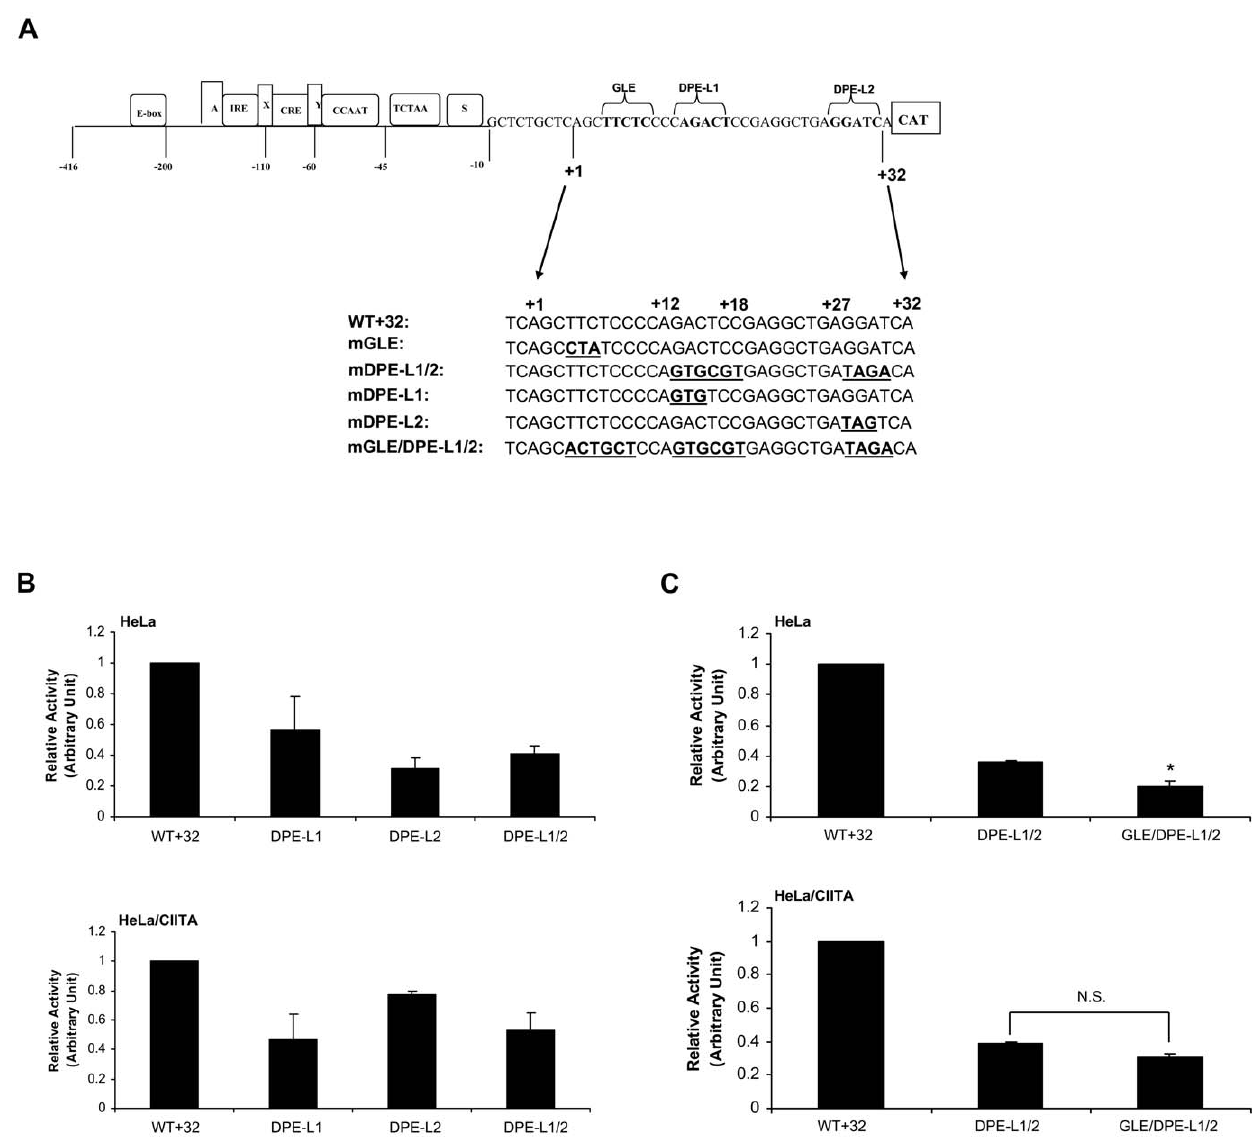
Figure 3. DPE-L1 and DPE-L2 functions are not additive. A) Schematic illustration of DPE-L1, DPE-L2, GLE, DPE-L1/2 and GLE/DPE- L1/2 mutants. Double and triple mutations of DPE-L1, DPE-L2, and GLE were designed to encompass the entire region of the each element identified by the scanning mutations. Thus, the mutations in the DPE-L1/2 double promoter mutant extended across + 13 to 18 bp and + 27 to + 30 bp and the GLE/DPE-L1/2 triple promoter mutant included mutations at + 4 to + 9 bp, + 13 to 18 bp and + 27 to + 30 bp. The single GLE and DPE-L1 and DPE-L2 mutations were the same as shown in Figure 2. B) The promoter activity of DPE1/2 is indistinguishable from that of either of single DPE mutants. The two single mutant constructs and the double DPE mutant construct were transfected into HeLa cells or HeLa/CIITA cells and the promoter activity was determined relative to wild type promoter (WT + 32). C) GLE functions independently of DPE-Ls in basal transcription, but not in activated transcription. The double mutant DPE-L1/2 and the triple mutant GLE/DPE-L1/2 constructs were transfected into HeLa cells or HeLa/CIITA cells and their activities were compared.